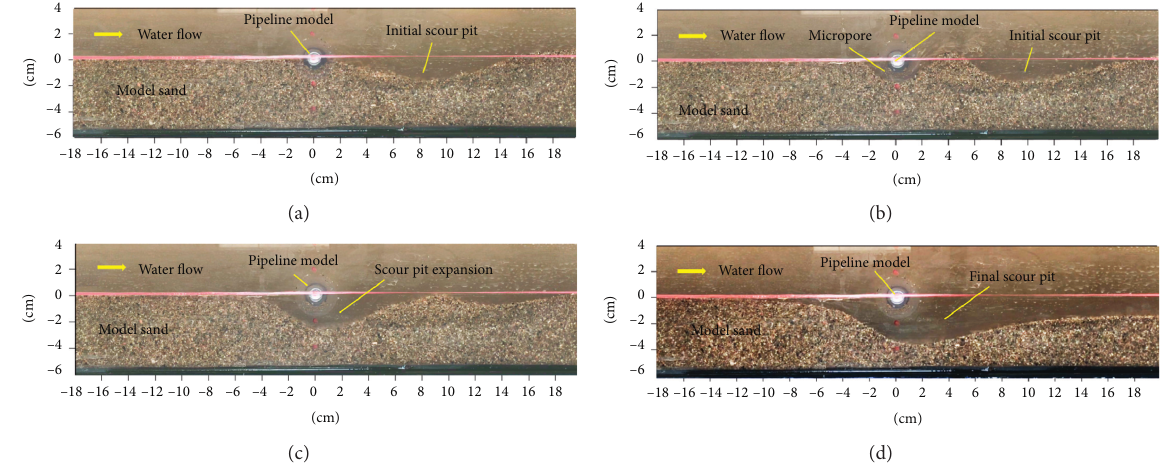
Figure 8: Local scour process around sandy riverbed pipelines: (a) scour start-up stage, (b) micropore formation stage, (c) scour extension stage, and (d) scour equilibrium